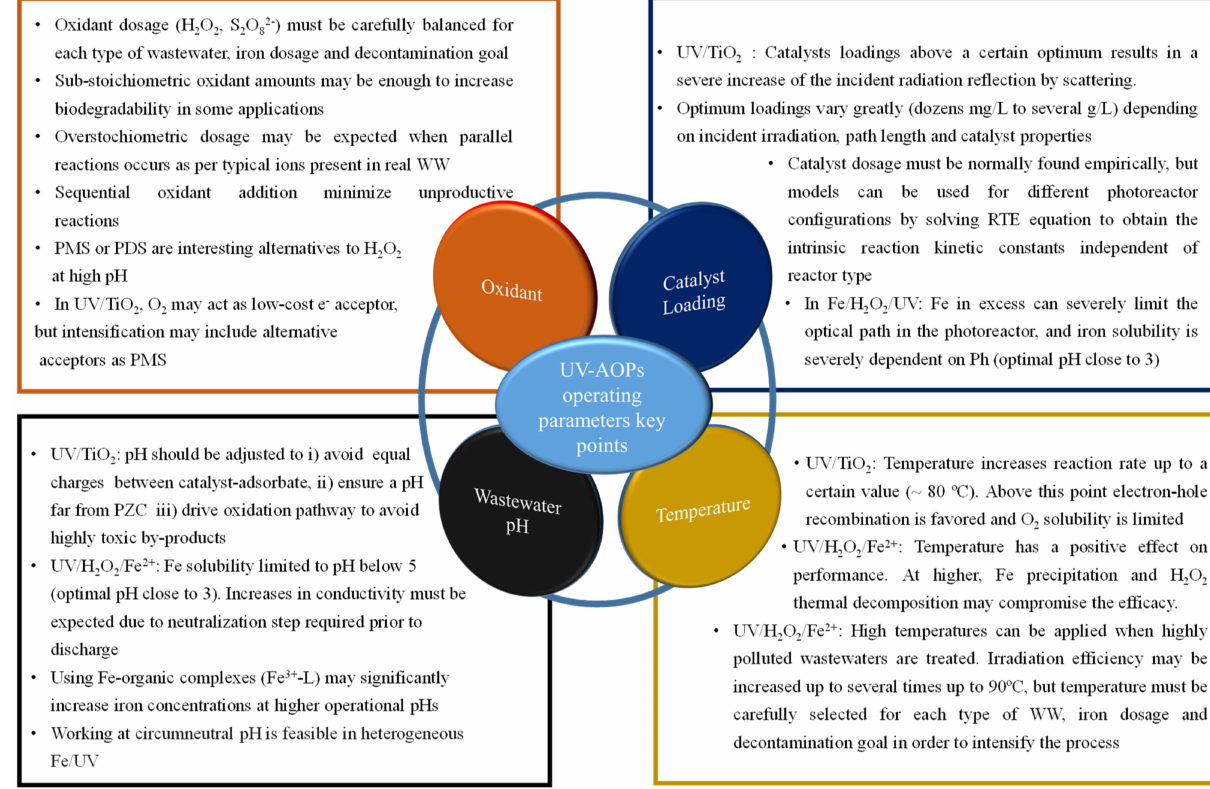
Figure 2. Key aspects for the optimisation of operating conditions in